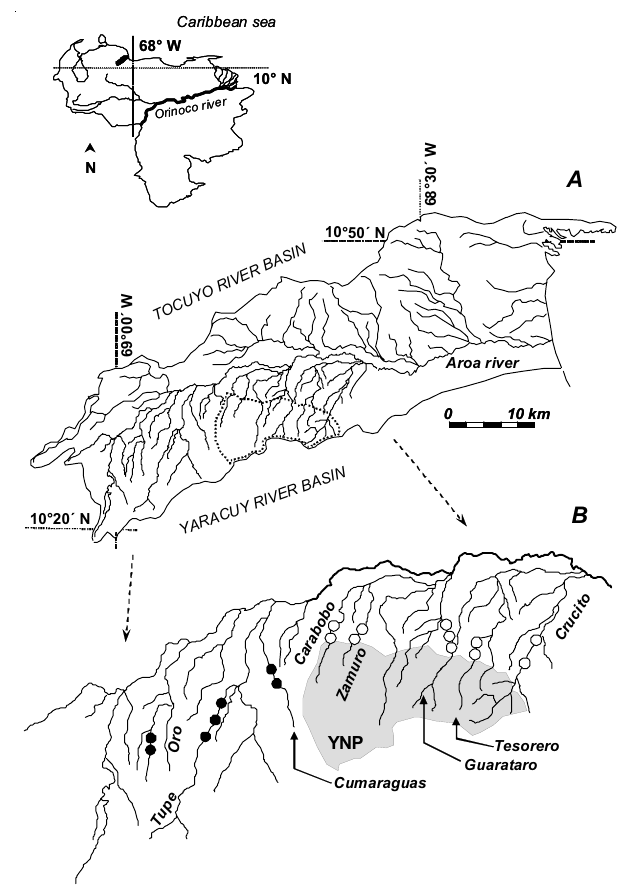
Fig. 1. A: The Aroa River basin. The Yurubí National Park (YNP) is indicated by the shaded polygon. B: each circle indi- cates one or more sample localities. The white circles de- noted tributaries in group 1 (G1) and black circles are tributar- ies in group 2